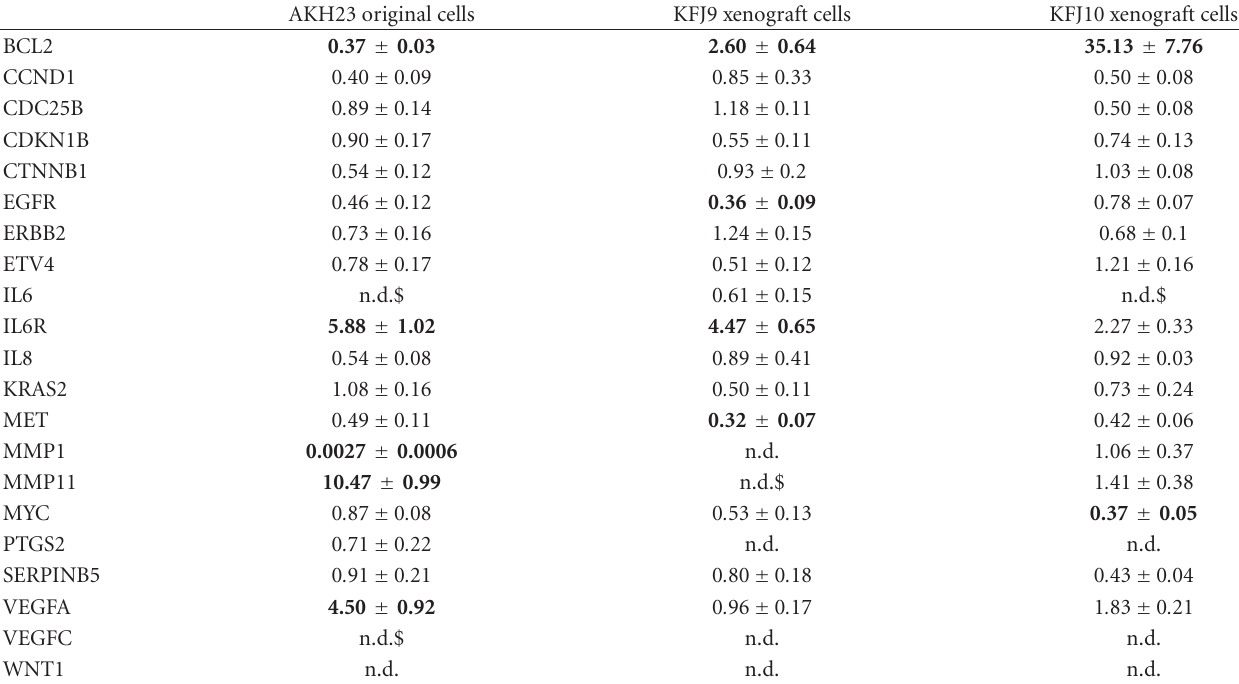
Table 5: Relative di ff erences in gene expression levels (n-fold) within tumour samples compared to derived cell cultures. n.d.: not determinable, Ct values obtained with cDNA derived either from cultured cells ($) or from both tumour samples and cells were below threshold ( >